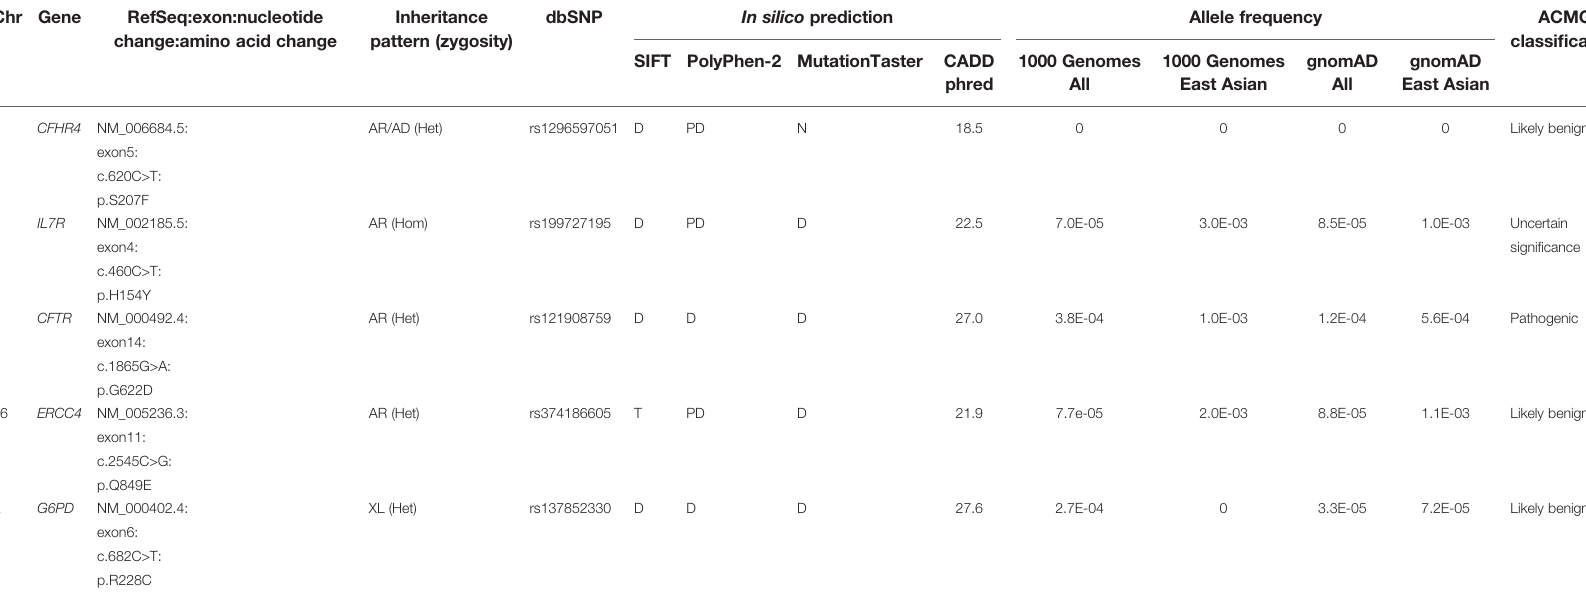
TABLE 2 | List of nonsynonymous single nucleotide variants (SNVs) found in the inborn errors of immunity (IEI) genes after variant fi ltering. Chr